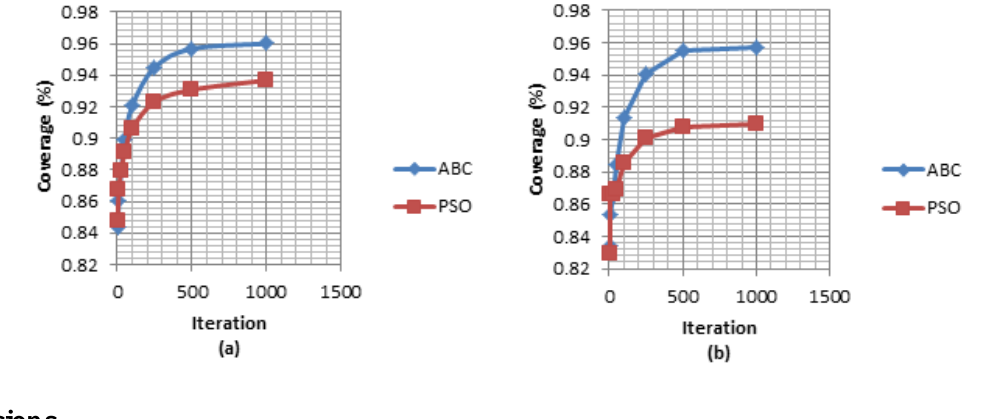
Figure 4. Development of the populations through the iterations for ABC and PSO algorithms: (a) the average of 30 runs, (b) the most difference in a